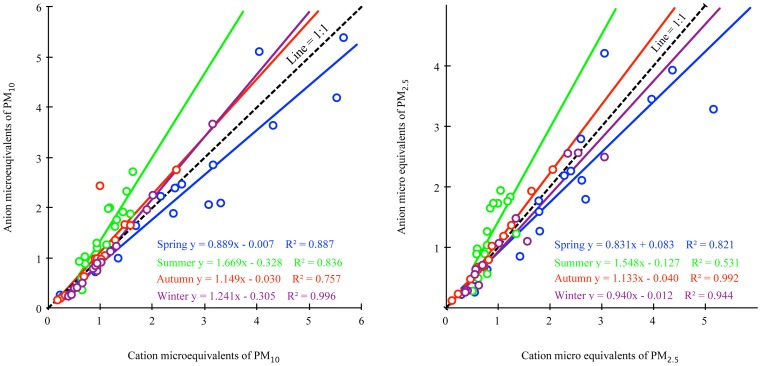
Total anions versus total cations. (All data were included and categorized by season, p<0.001 for all regressions.).